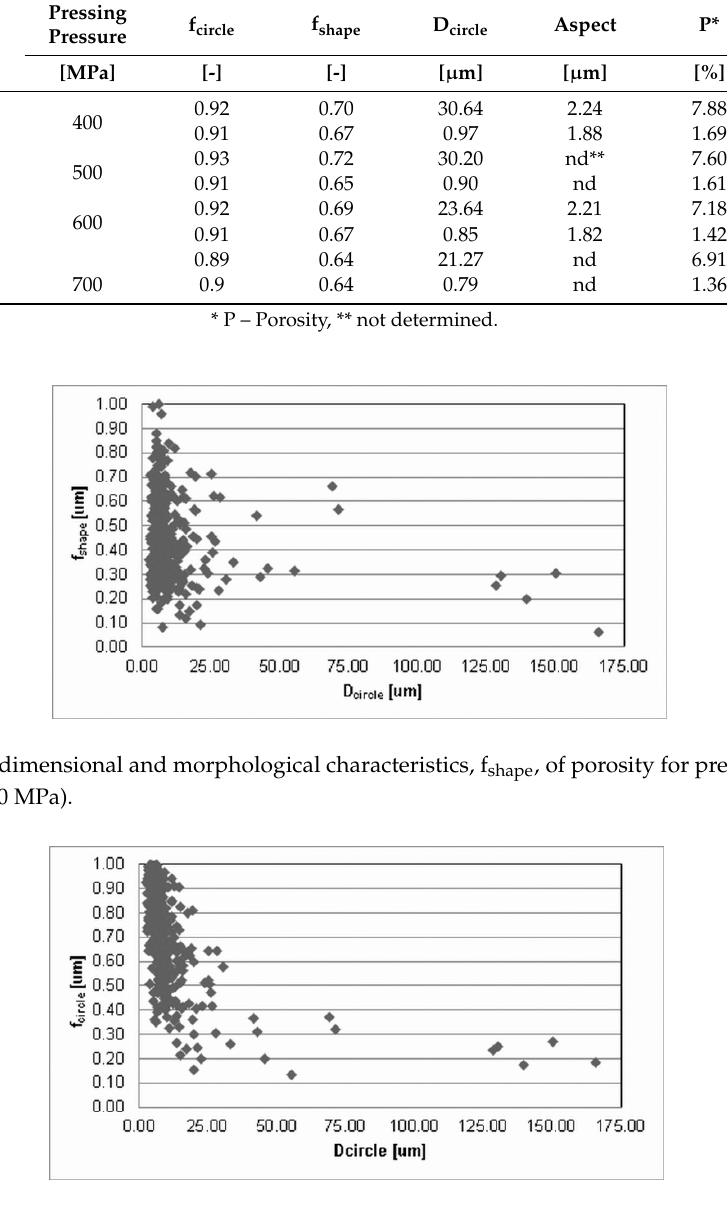
Figure 3. The dimensional and morphological characteristics, f circle , of porosity for press-and-sinter specimens (400 MPa).